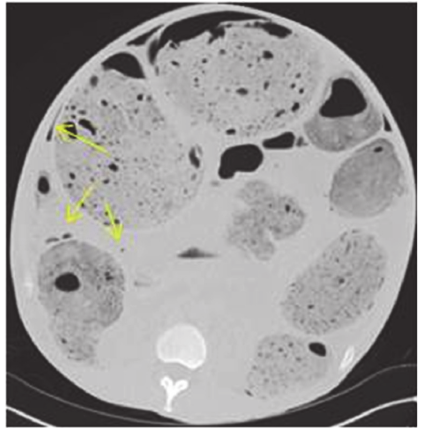
Figure 4: Axial CT images on soft tissue windows showing the anterior ascending colon perforation site (arrow). The ascending colon has collapsed a little relative to the distal bowel. No definite intramural gas in the wall. There is right-side pneumoperitoneum (arrowhead).